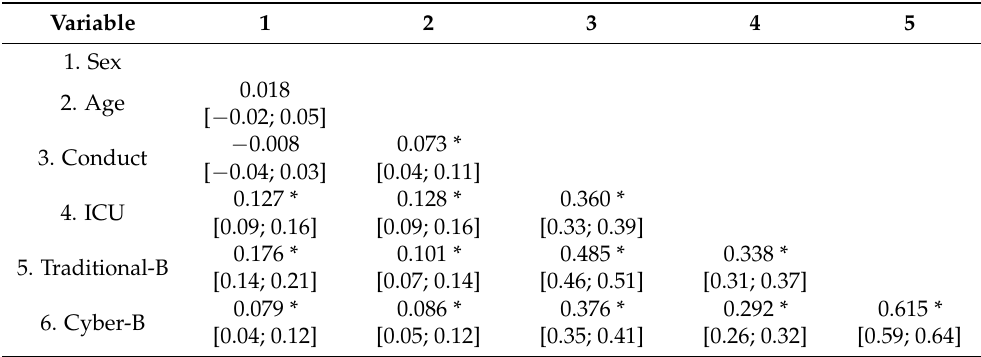
Table 2. Summary of intercorrelations (and 95% confidence intervals) for the considered variables.